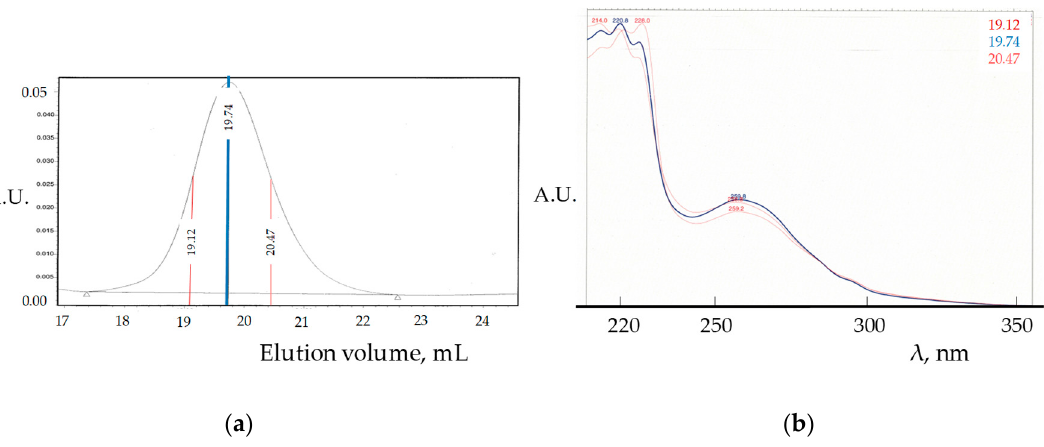
Figure 5. SEC eluogram of a copolymer obtained after simultaneous addition of comonomers (STEM 1, Table 1 and Figure 1a,b). ( a ) UV PDA trace at 260 nm; ( b ) overlaid UV spectra of fractions eluting at 19.12 mL, 19.4 mL and 20.47 mL.